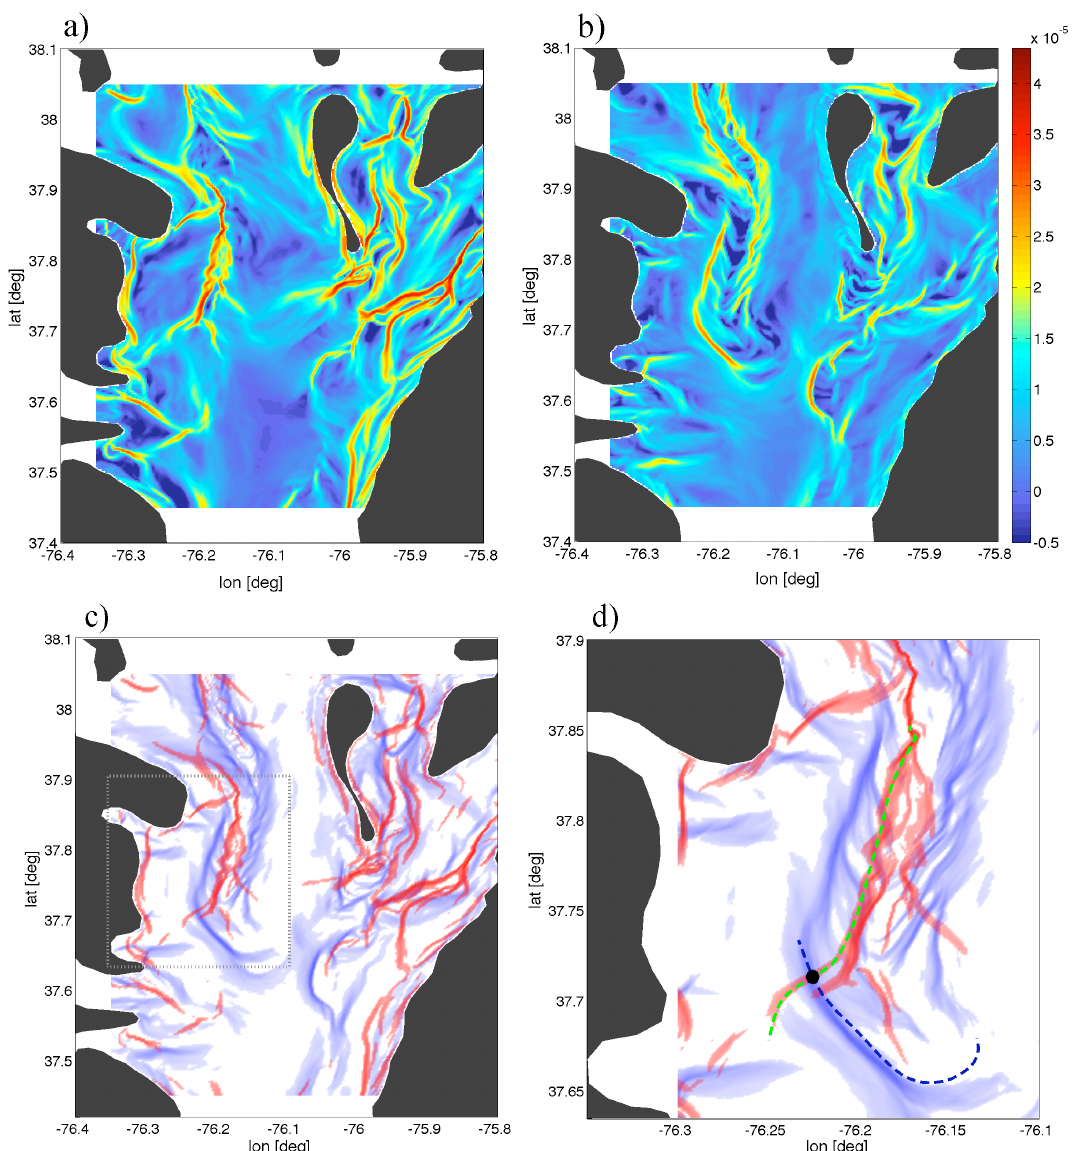
Fig. 8. Examples of the backward FTLE field (a) and the forward FTLE field (b) in the Chesapeake Bay computed in the surface flow with T =24h in the midsection of the bay. The strong ridges (red) in the backward FTLE field (a) are indicative of attracting structures and the ridges in the forward FTLE fields in (b) are indicative of repelling structures in the flow field. Identification of dominant segments which would be long enough (the arc length sense) for meaningful transport analysis proves difficult in the flow. (c) Superposition of the FTLE fields shown in (a)–(b). The intersections of the ridges of the forward and backward FTLE fields represent, in principle, likely locations for distinguished hyperbolic trajectories. However, such intersections are not time-invariant, at least in the surface flow of the Chesapeake Bay. Similarly, paths of hyperbolic instantaneous stagnation points in the bay are generally too short-lived to serve as a useful initial guess in the DHT finding algorithm (see Ide et al., 2002; Mancho et al., 2006 and Sect. 3). In the situations where relatively short segments of DHTs can be identified the stable and unstable manifolds of these DHTs tend to align well with the respective ridges of the FTLE fields, as shown in (d) ; the dashed green curve represents the instantaneous geometry of the unstable manifold, and the dashed blue curve is the stable manifold of a hyperbolic trajectory whose instantaneous location is denoted by the black